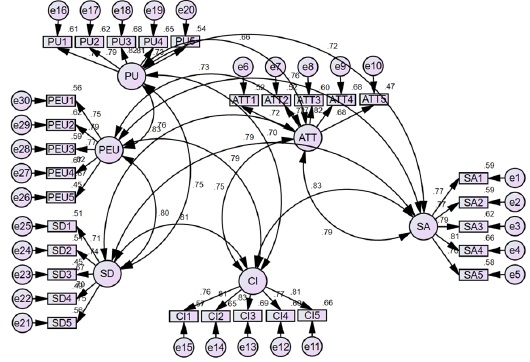
Fig. 2. Confirmatory Factor